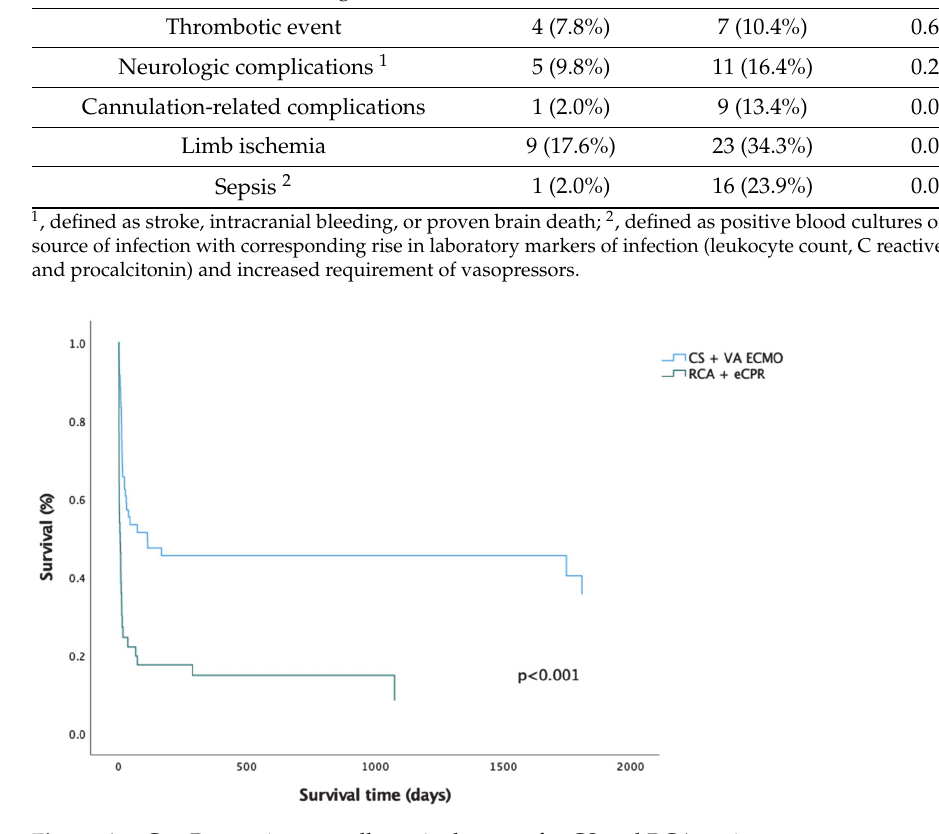
while on ECMO; 7 , calculated only for patients not censored. Table A2. Comparison of major complications in survivors at 30 ‐ days and dead.